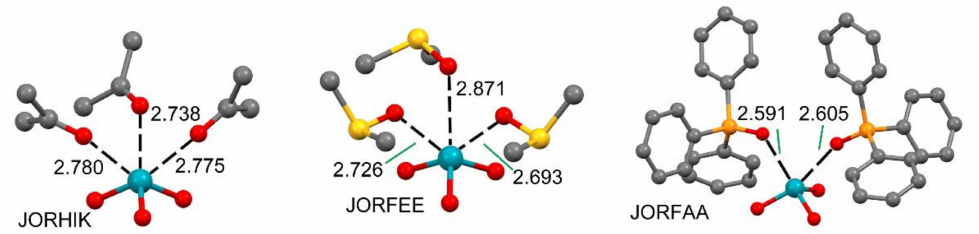
Figure 14. Partial views of the X-ray structures corresponding to CSD reference codes JORHIK ( left ), JORFEE ( middle ), and JORFAA ( right ) corresponding to bis(acetone)-trioxo-xenon acetone-trioxo-xenonacetonesolvate, ( µ -dimethylsulfoxide)-bis(dimethylsulfoxide)-hexaoxo-di-xenon, and bis((triphenyl)phosphine oxide)-trioxo-xenon, respectively. Distances in Å. The H atoms are omitted for clarity.